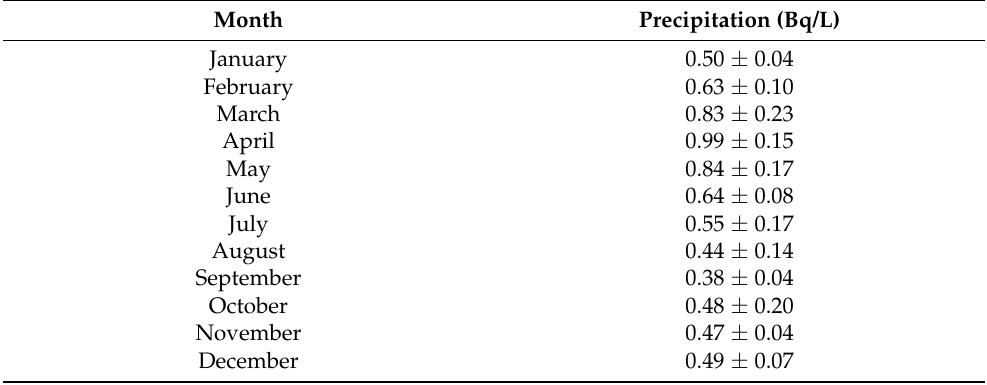
Table 1. The monthly mean tritium concentrations in the precipitation at Hirosaki City (2018 to 2020).